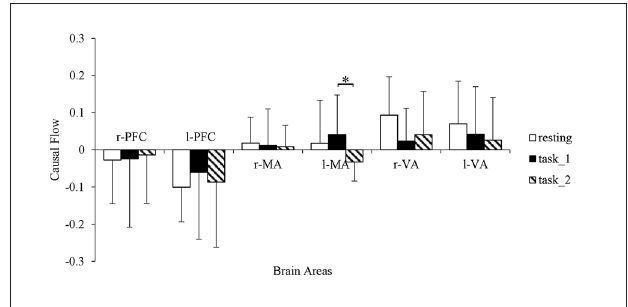
FIGURE 8 | Comparison of the causal flows in the six brain areas among the three states. “ ∗ ” Indicates a statistically significant change. Abbreviations: r-PFC, right prefrontal cortex; l-PFC, left prefrontal cortex; r-MA, right motor-related areas; l-MA, right motor-related areas; r-VA, right vision-related areas; l-VA, left vision-related